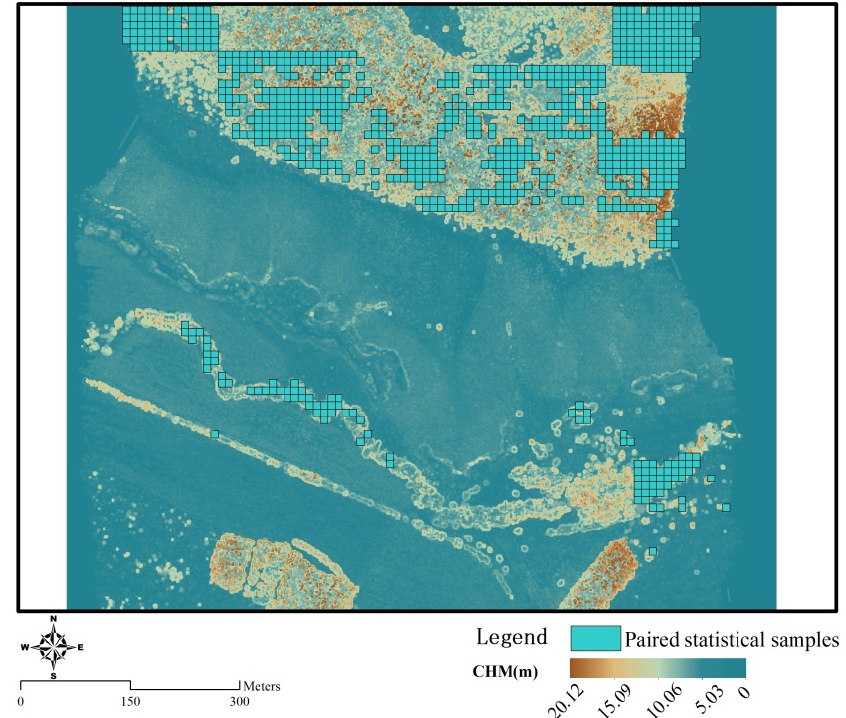
Figure 6. The distribution of statistical samples; the cyan area contains the paired experimental samples.